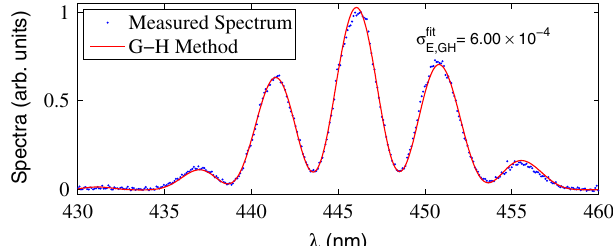
FIG. 17. (Color) Measured optical klystron spectrum with a very small energy spread. The electron beam energy is 280 MeV and the single-bunch beam current is 0.045 mA. To produce sub- stantial spectral intensity modulation, the buncher magnet is (cid:6) 56 . The G-H method powered with a large current with N d is used to find the energy spread of the beam, (cid:1) fit E ¼ ð 6 : 00 (cid:9) 0 : 015 Þ (cid:2) 10 (cid:1) 4 . The background of the measured spectrum has been subtracted.